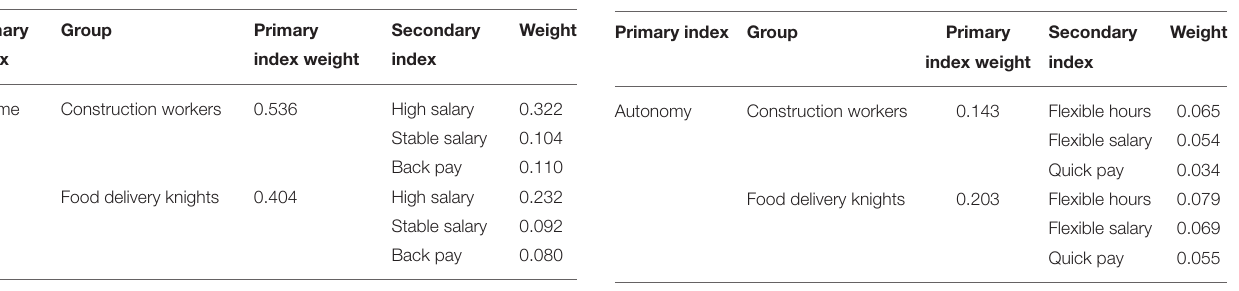
TABLE 5 | Weights of index